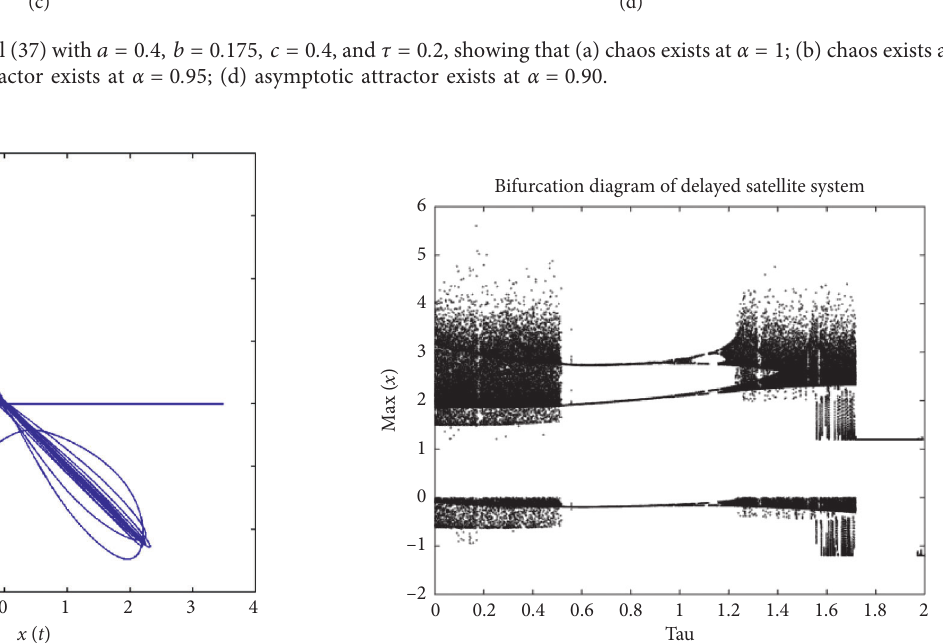
Figure 7: Bifurcation diagram of FOS delay model (37) with a � 0 . 4 , b � 0 . 175 , c � 0 . 4 , and α � 1 and varying τ